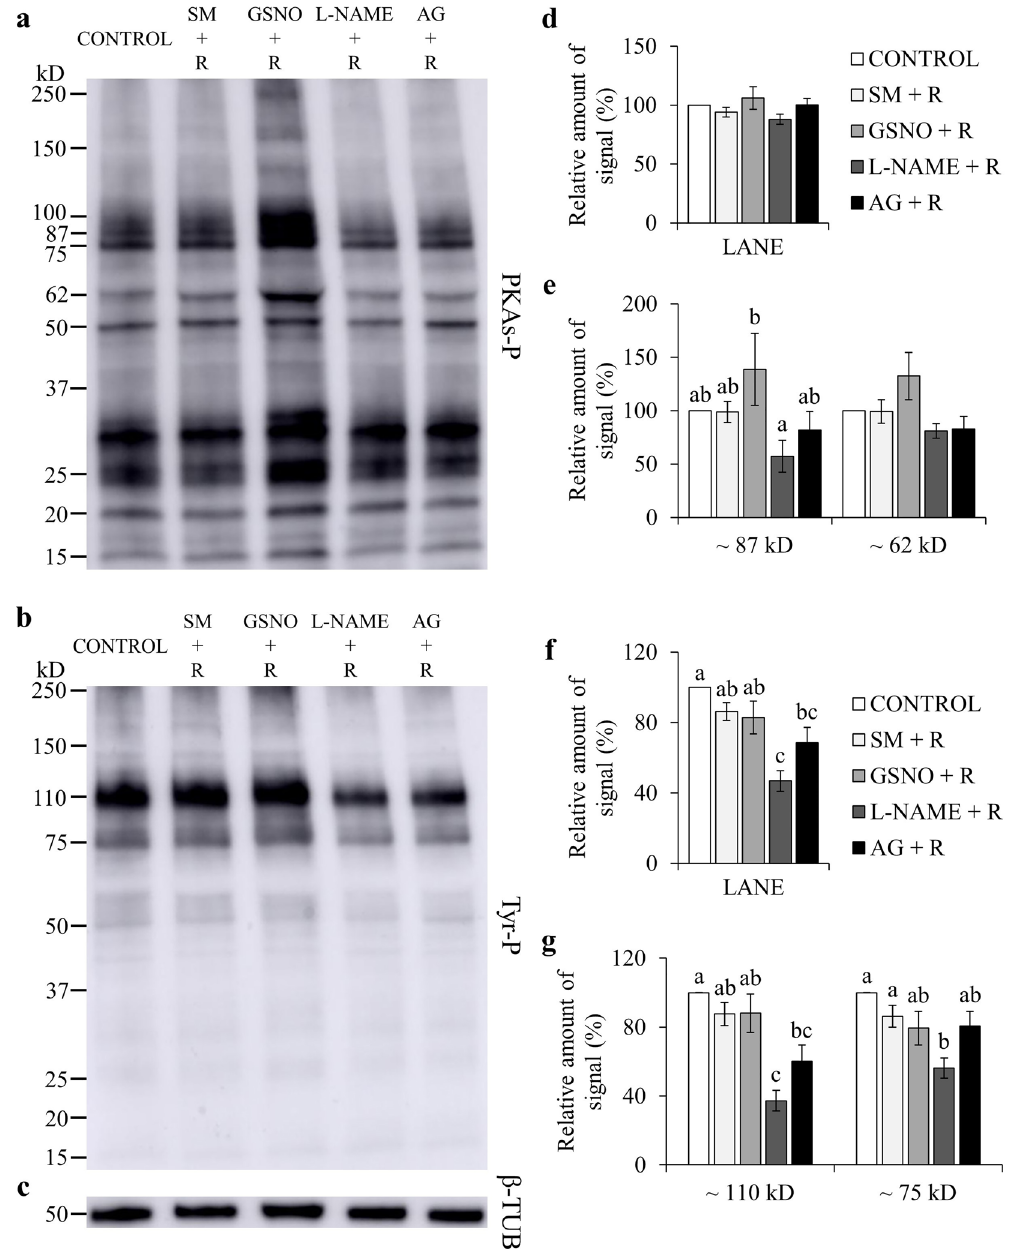
Figure 2. Effect of L-Arginine (R), GSNO, l-NAME and AG on PKA substrates (PKAs-P) and tyrosine phosphorylation (Tyr-P). Sperm were incubated for 4 h under capacitating conditions in the absence of any treatments (CONTROL) or in the presence of L-Arginine, the substrate for NO synthesis, GSNO, a NO donor, l-NAME and AG (both NOS inhibitors). ( a,b ) Sperm protein extracts (n = 7) were analyzed for phosphorylation by Western blot using anti-PKAs-P or anti-Tyr-P as first antibodies, respectively. ( c ) β-tubulin (β-TUB) was used as a protein loading control. For signal quantification, each lane was normalized to its β-TUB optical density value. ( d–g ) Relative amount of signal quantified in each membrane using ImageQuant TL v8.1 software for PKAs-P and Tyr-P, respectively. SM: Sperm Medium. Different letters (a, b, c) indicate statistically significant differences ( P < 0.05) between groups. Images ( a – c ) were cropped from the corresponding blot showed in Supplementary Fig. S2 (lanes